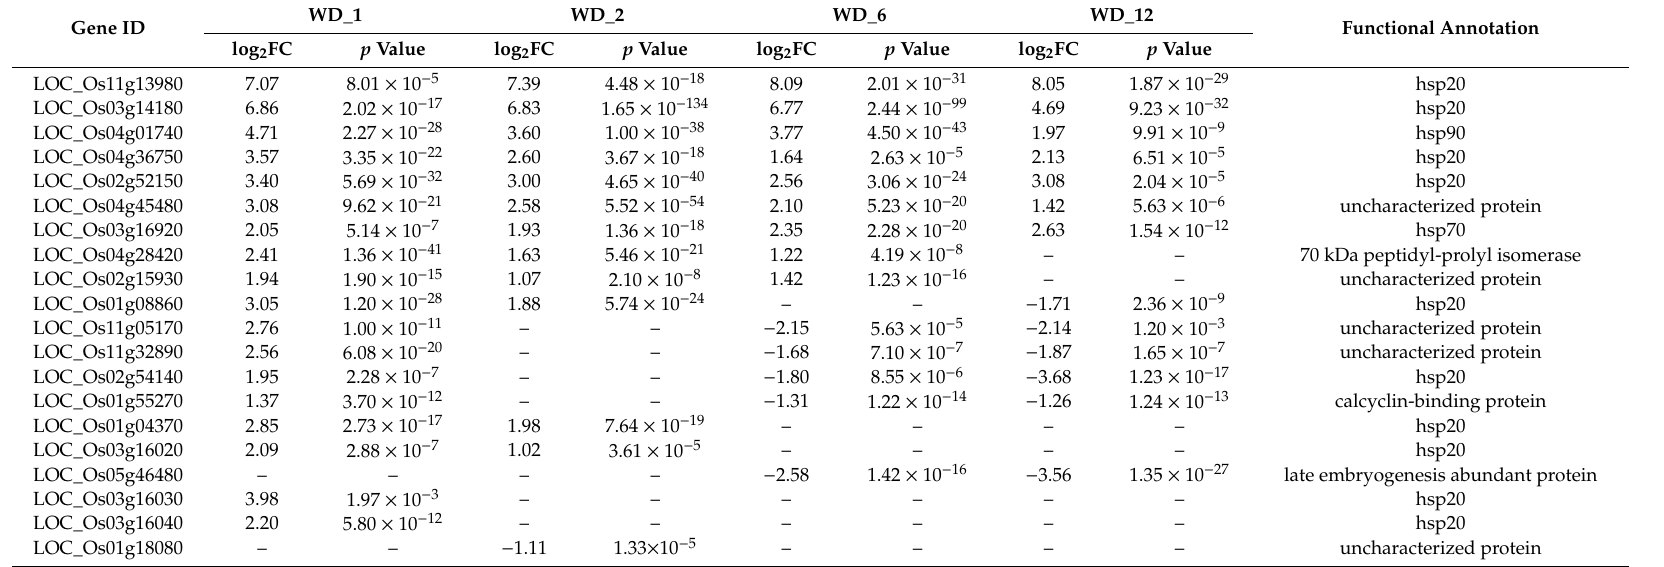
Table 1. Common DEGs compared with the transcriptional profiles of the pollinated pistil [16] and anther [17]. Gene